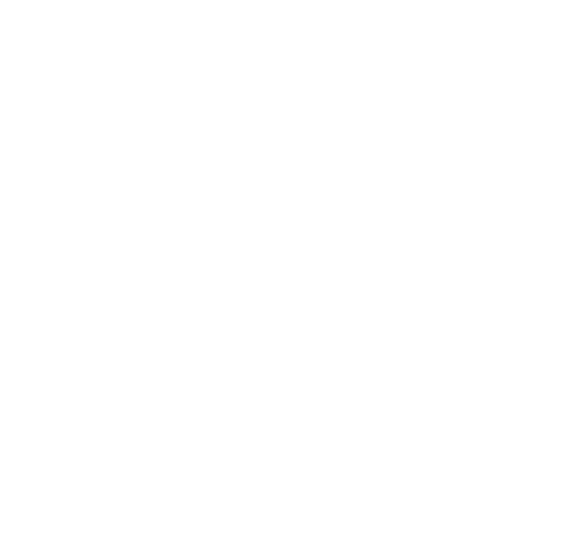
Figure 6. The expression pattern of LysM-RLK genes in response to Sclerotinia clerotiorum infection. The color boxes indicate expression values, the lowest (green), medium (black), and the highest (red). R, S, and C indicate resistant (J964), susceptible (J902), and control plants, respectively.